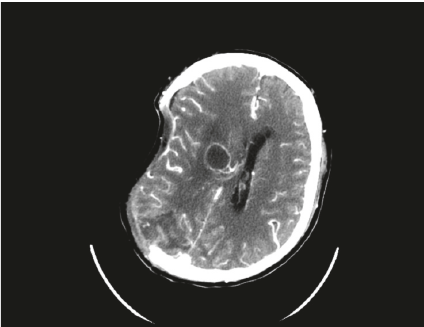
Figure 6: Contrast-enhanced CT of head 30 days after the initial ischemia showed a ring-enhancing cystic lesion in the right basal ganglia with perilesional oedema, which compressed right lateral ventricle with midline shift towards left suggestive of